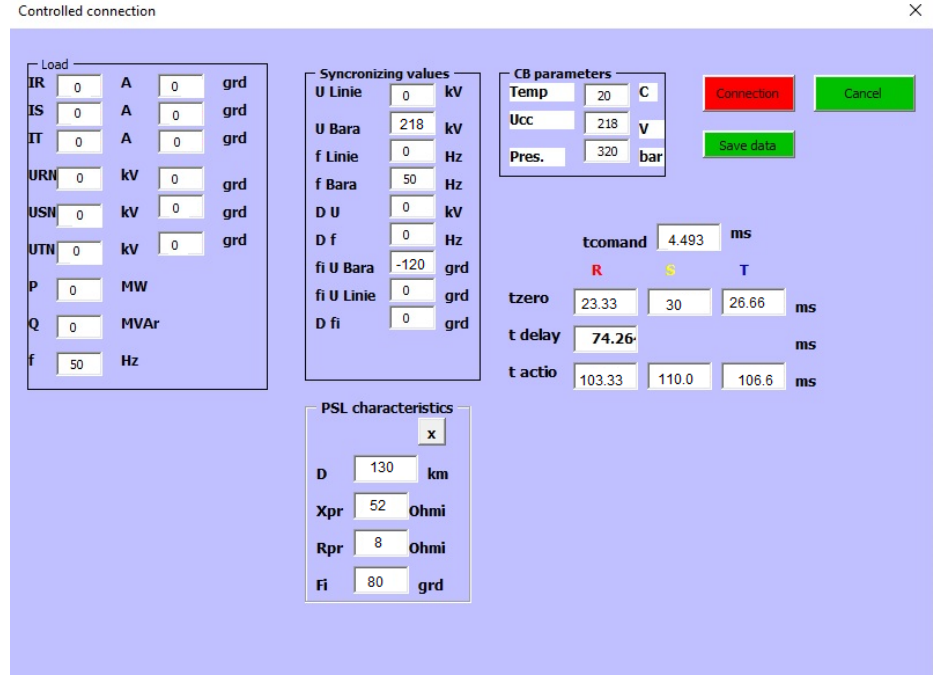
Figure 28. The control screen of the circuit breaker’s controlled connection.